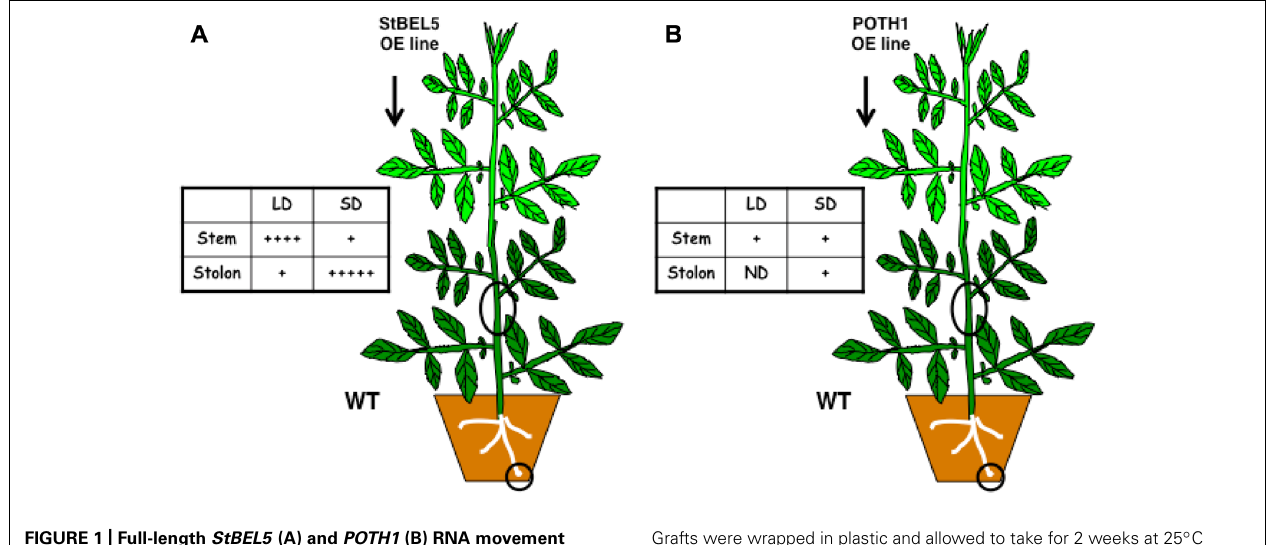
FIGURE 1 | Full-length StBEL5 (A) and POTH1 (B) RNA movement in a downward direction in response to photoperiod in soil-grown heterografts. Both RNAs were quantified using gene-specific primers that amplified only transgenic RNA in real-time qRT-PCR and their relative abundances are shown with a ( + ) sign.WT sample sources are indicated by black circles.The transgenic lines expressed full- length StBEL5 or POTH1 RNA driven by the 35S CaMV